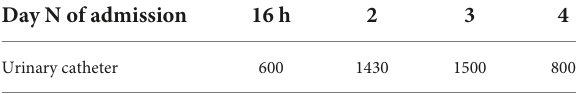
TABLE 1 Preoperative catheterization urine volume statistics